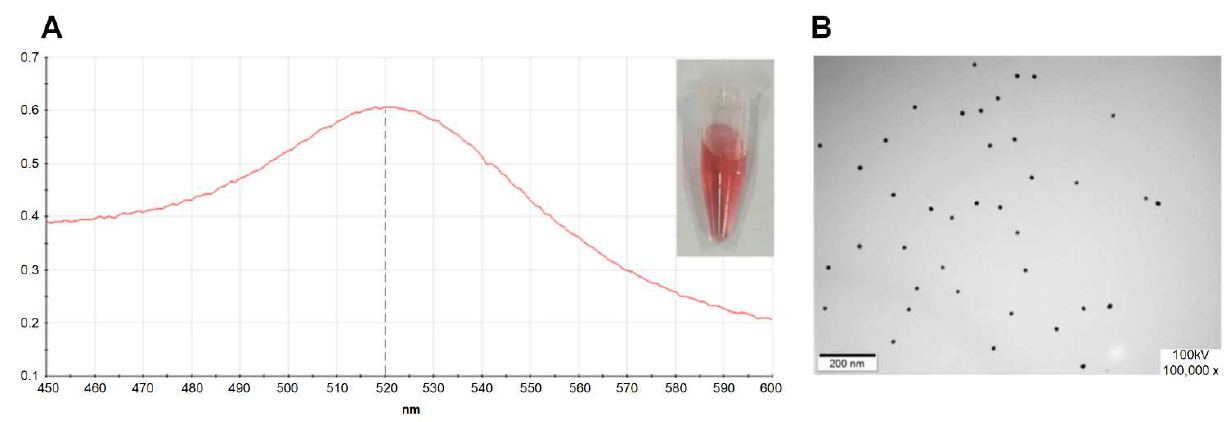
Figure 7. Characterization of colloidal gold. ( A ) UV-visible absorption spectra of the AuNPs. ( B ) TEM image of the AuNPs.